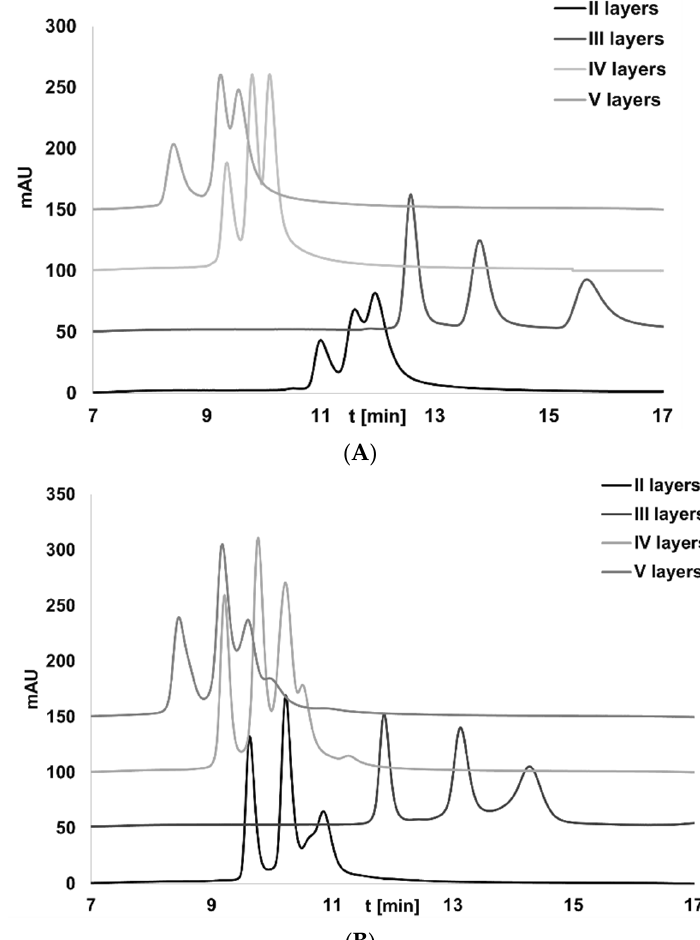
Figure 4. Separation of oligonucleotide mixtures using dendrimer anion exchangers: ( A ) mixture of OL1, OL2, OL3; ( B ) mixture of OL4, OL5, OL6. Experimental conditions: gradient elution program 0 min.—0.125 M NaCl, 5 min.—0.4 M NaCl, 15 min.—0.4 M NaCl; pH 6.9; flow rate 0.3 mL/min; column and autosampler temperature 35 °C; injection volume: 2 µL; UV detection λ = 260 nm; elution order for ( A ) OL3, OL2, OL1; for ( B ) OL6, OL5, OL4.